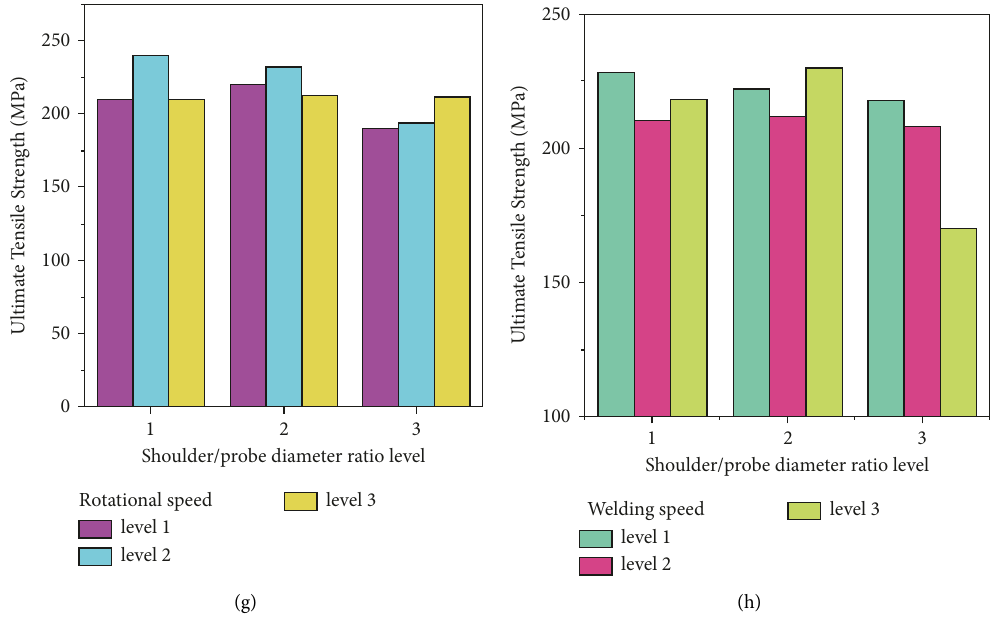
Figure 4: Ultimate tensile strength of different weld speeds and diameter